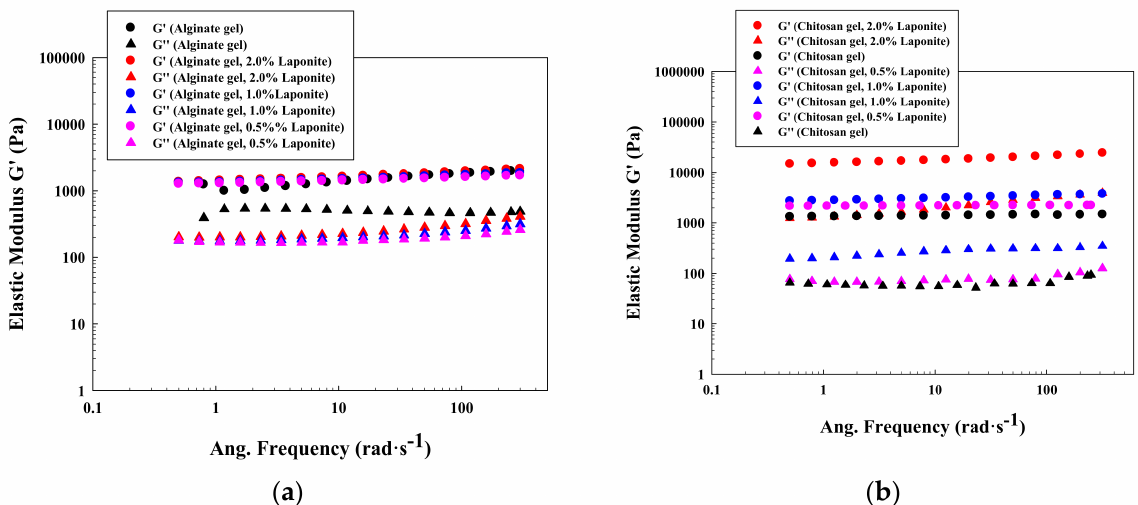
Figure 7. Oscillatory plots with the effect of Laponite ® on ( a ) alginate gels; ( b ) chitosan